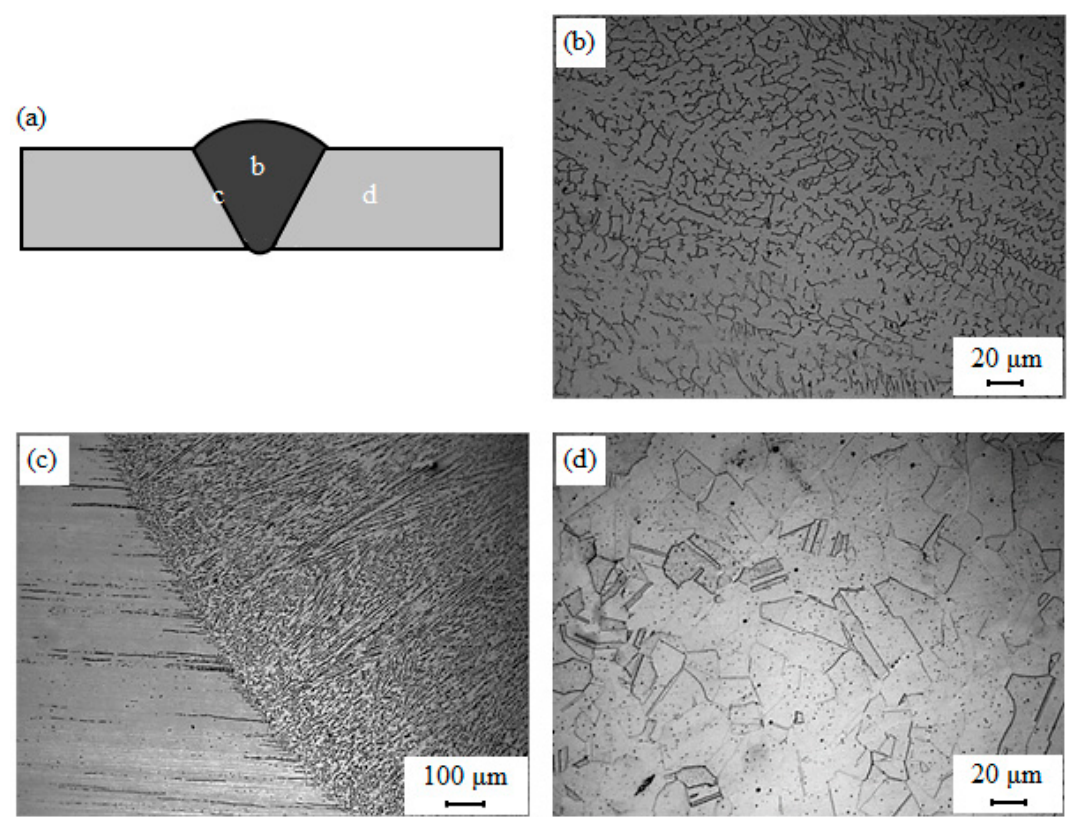
Figure 6. SEM micrographs of ( a ) schematic representation of welded joint; ( b ) weld metal; ( c ) heat- affected zone (HAZ) and ( d ) base metal.